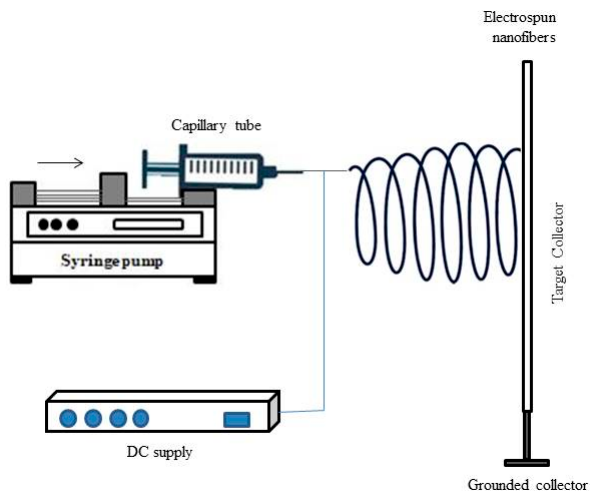
Figure 10. Simplified diagram of an electrospinning device, which consists of four main components such as power supply, syringe pump, metallic needle, and grounded collector. Reprinted with permission from Ref. [2]. Copyright 2019 Abdalla Eltom et al.